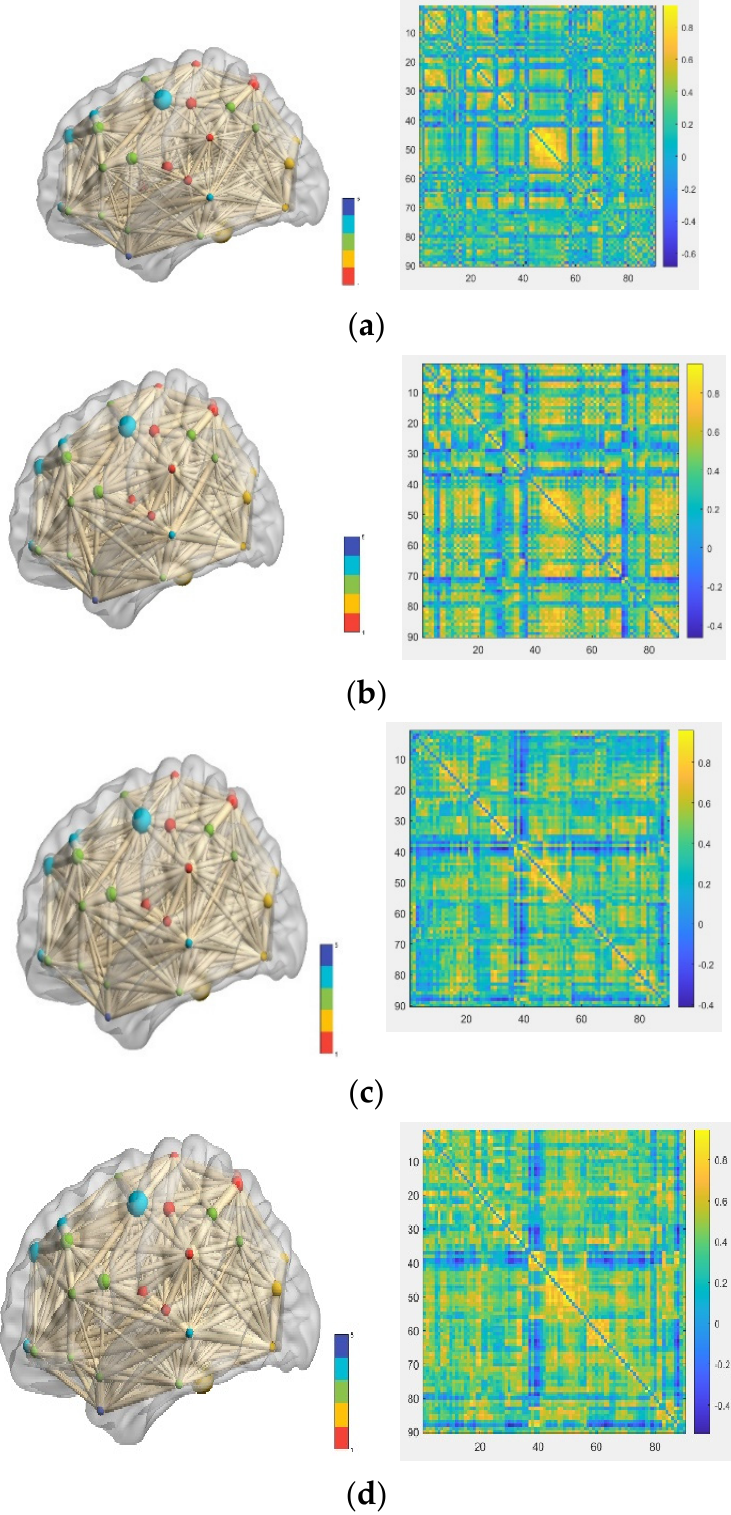
Figure 3. Brain network visualization and functional connection matrix. ( a ) Brain network visualiza- tion and the functional connection matrix of N; ( b ) brain network visualization and the functional connection matrix of AD; ( c ) Brain network visualization and the functional connection matrix of sMCI; and ( d ) Brain network visualization and the functional connection matrix of